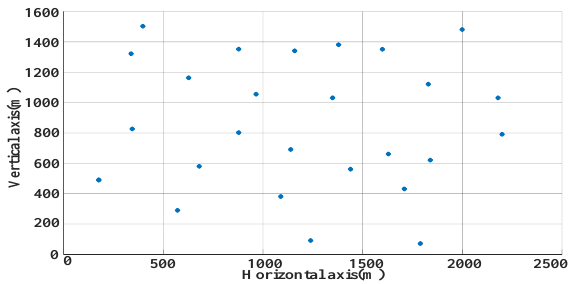
Figure 5. Spatial location map of 26 nodes.